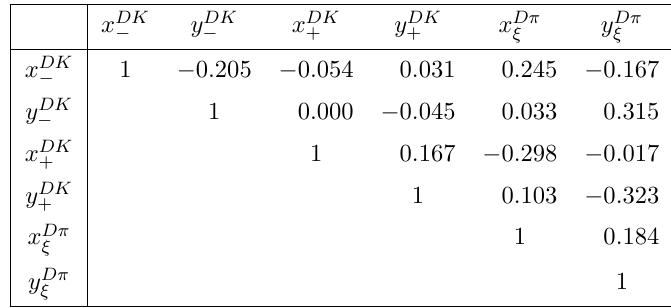
Table 7 . Statistical correlation matrix obtained for the Belle standalone data set.